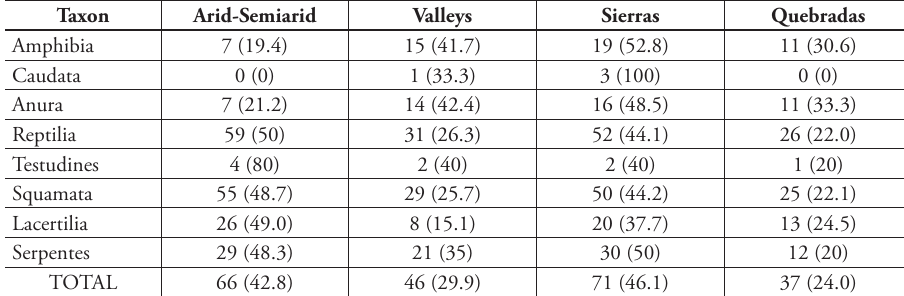
Table 3. Summary of the number of native species (% of total number of species of taxonomic group in Durango in parentheses) in different taxonomic groups found in different habitat types in Durango, Mexico (see text for description of the habitat